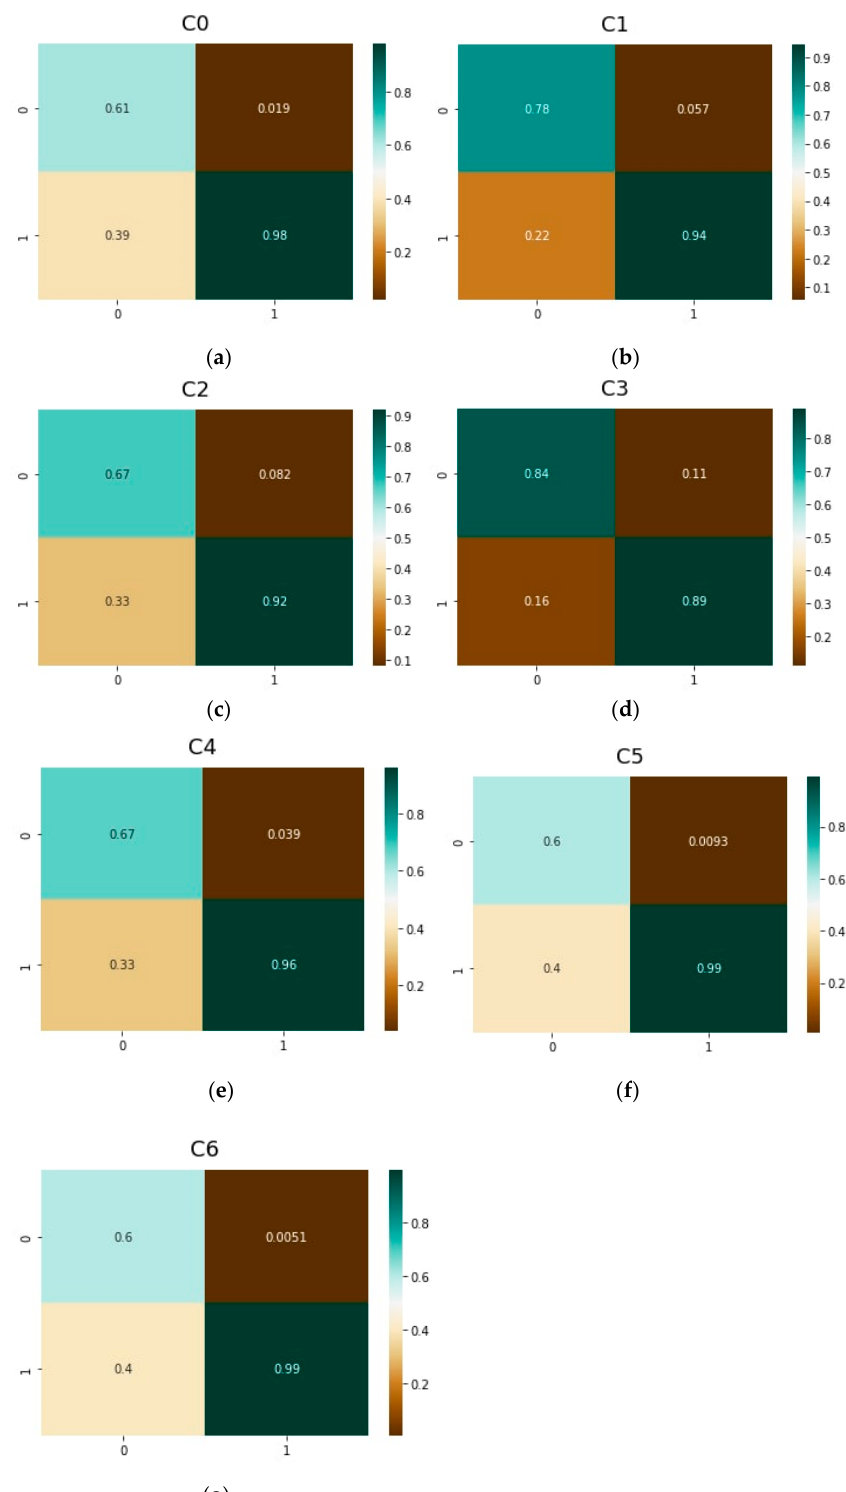
Figure 10. The multi-classification model based on vit-base-patch16-224. The confusion matrices for